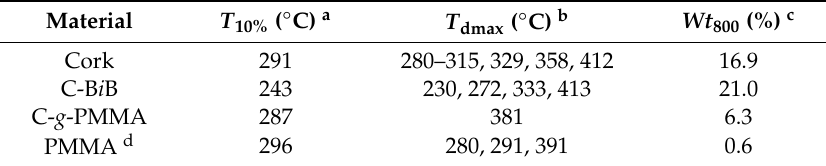
Table 2. TGA features of cork, C-B i B, C- g -PMMA and PMMA homopolymer.